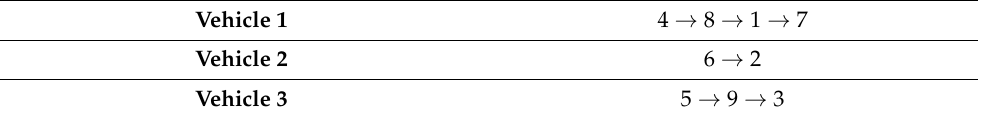
Table 4. Example of decoded